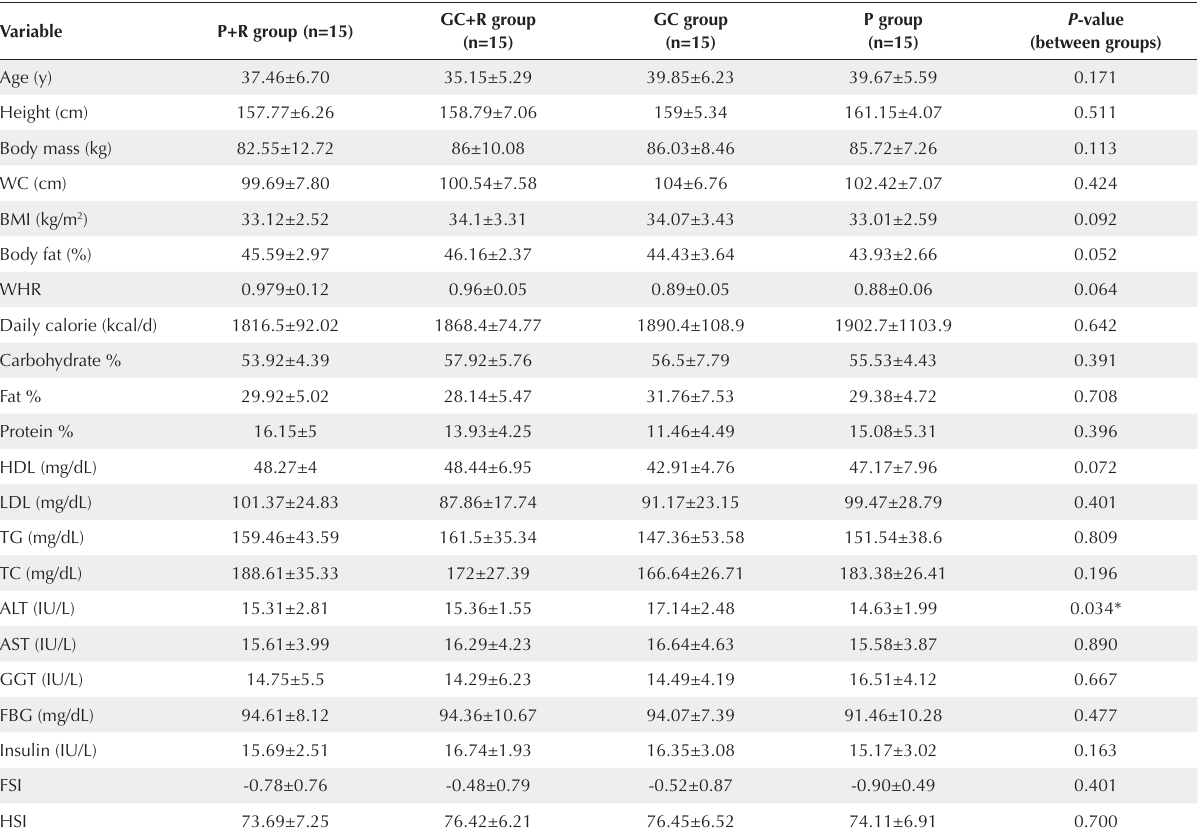
Table 1. Descriptive characteristics of P+R, GC+R, GC, and P groups at baseline